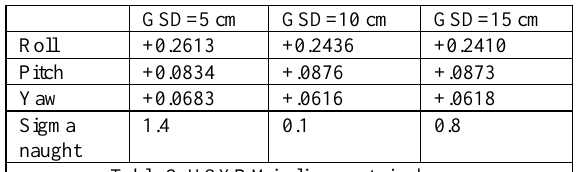
Table 2: UCXP Misalignments in degree